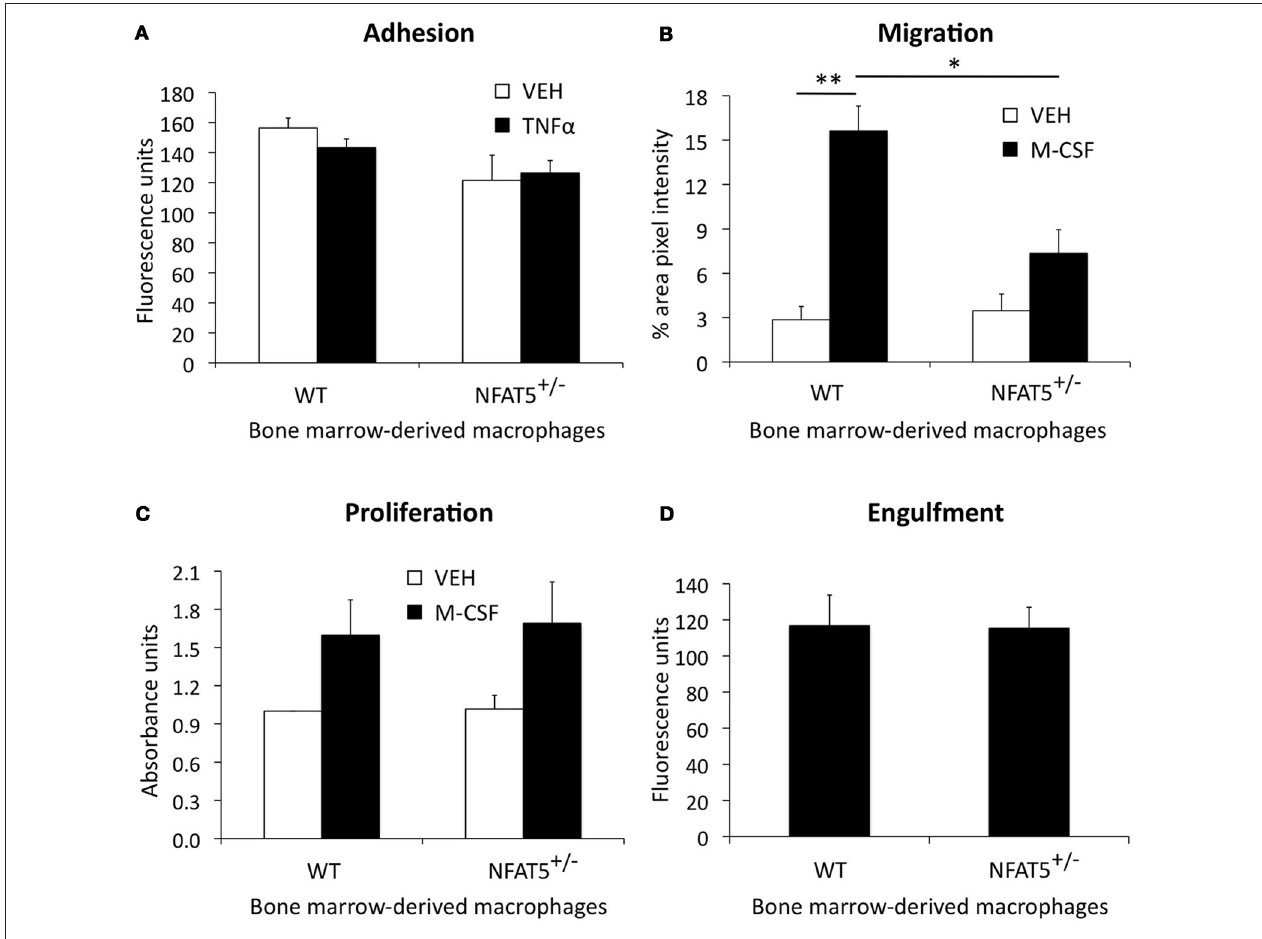
FIGURE 5 | NFAT5 deficiency impairs macrophage migration. Bone marrow harvested from WT and NFAT5 + / − mice was treated with M-CSF for 7 days to differentiate cells into bone marrow-derived macrophages (BMDMs). Functional analyses were then performed. BMDMs were tested